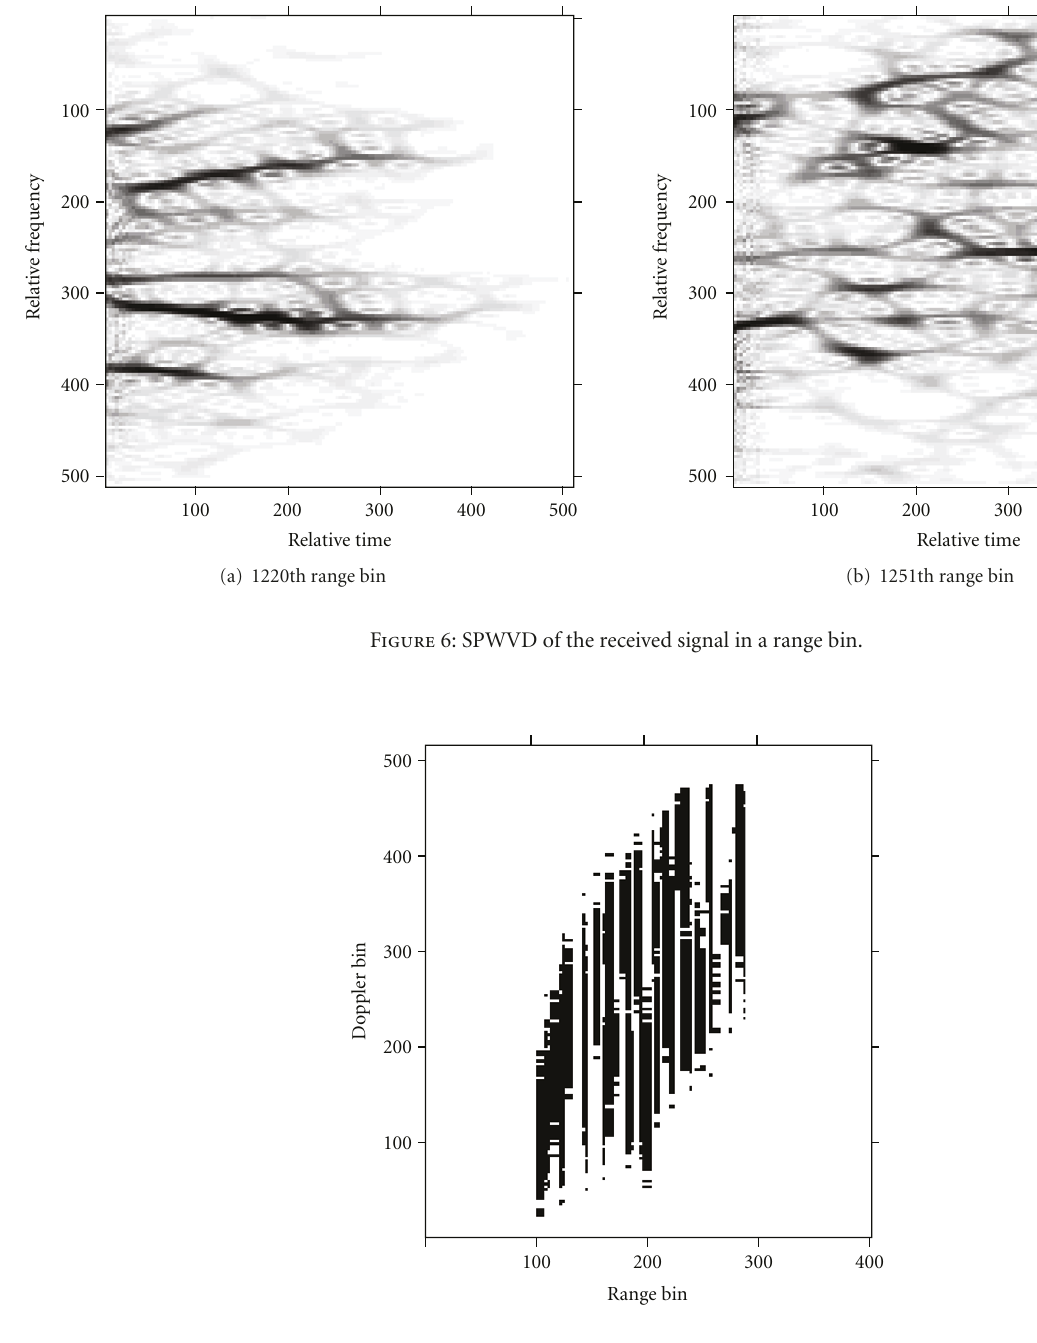
Figure 7: ISAR image of ship target based on the RD algorithm.